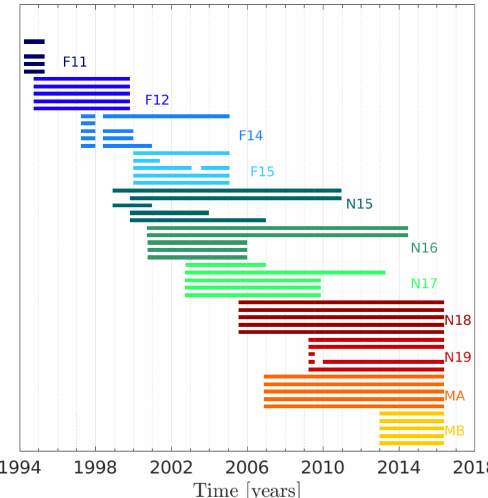
Figure 9. Usable microwave data records with cold NE (cid:49)T < 1K. The five bars per satellite correspond to the channels 1 to 5 (from top to